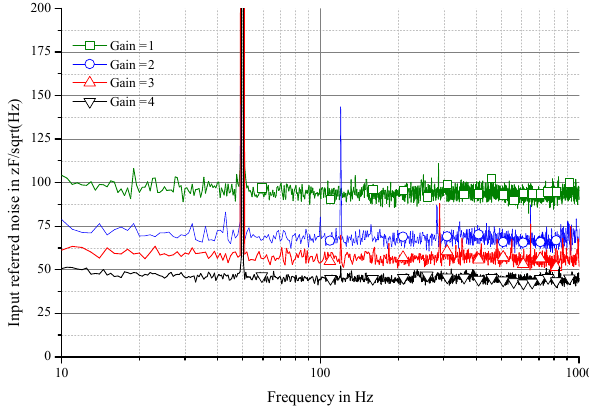
Figure 9. Measurement results of the input referred capacitance noise density.